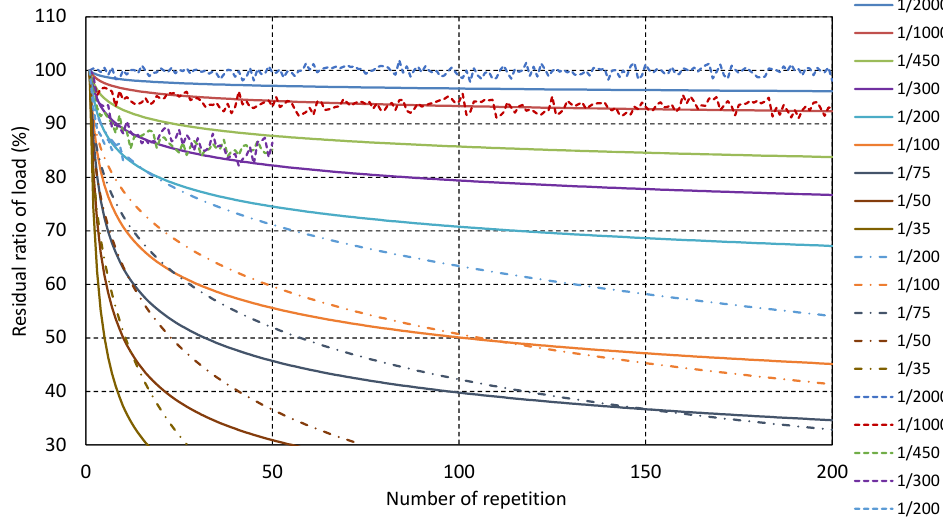
Figure 6. Comparison between estimated value and test result of load residual ratio. (Plywood) Solid line: prediction; dotted line: test result; dashed line: reference value [16]. The same operation as was carried out on the plywood was performed on a gypsum